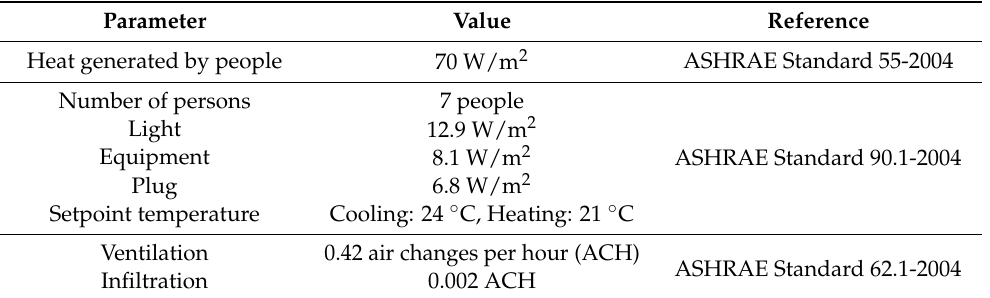
Table 3. Building load model conditions.